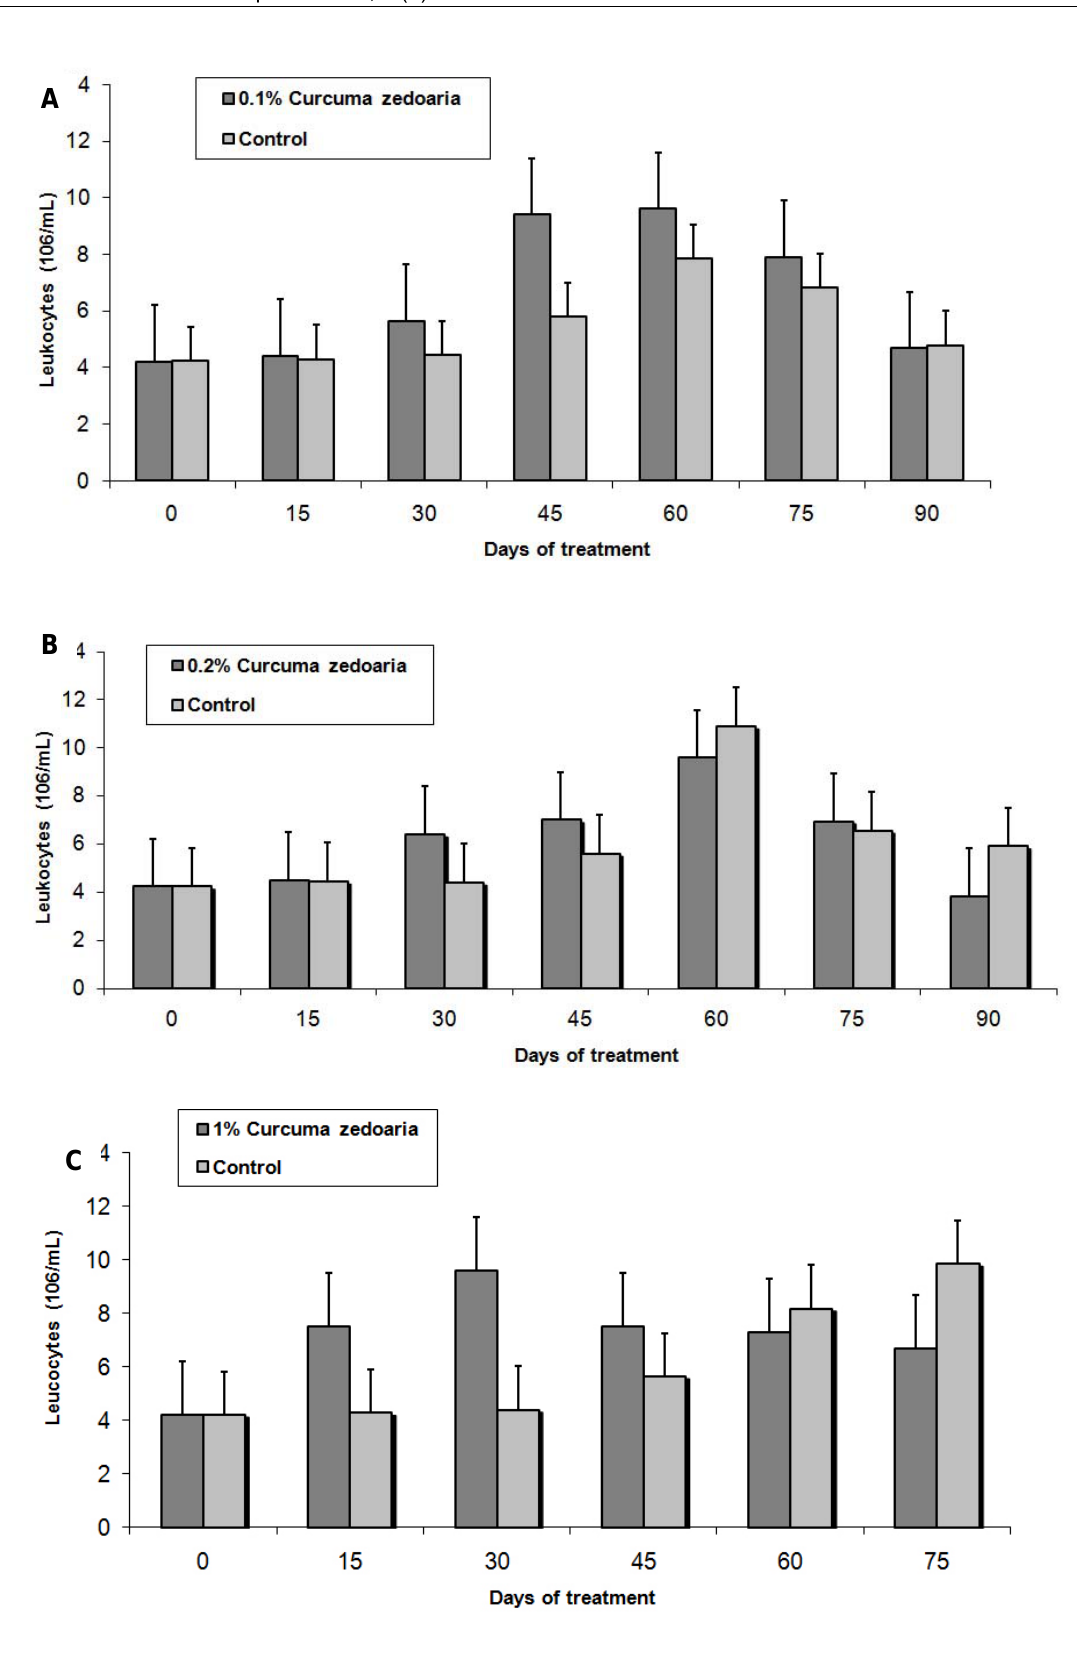
Figure 2. Analysis of total leukocytes in the blood of C57BL/6J mice treated with ( A ) 0.1%; ( B ) 0.2% or ( C ) 1% Curcuma zedoaria crude extract. Data are expressed as mean ±